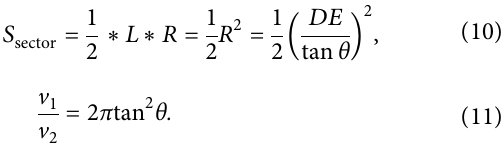
Figure 4: Actual wire